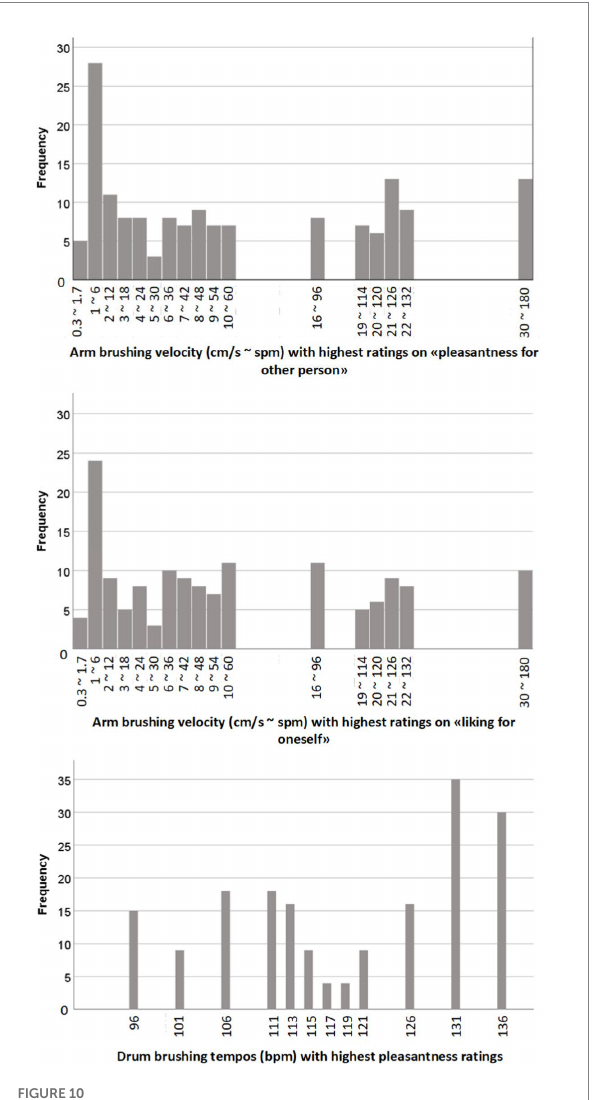
FIGURE 10 Histograms of the distributions of preferred arm brushing and drum brushing tempos for participants who gave two or fewer highest ratings. Upper: most pleasant velocity for other person ( N = 114); middle: most liked velocity for oneself ( N = 107), lower: most pleasant drum brushing tempo ( N =